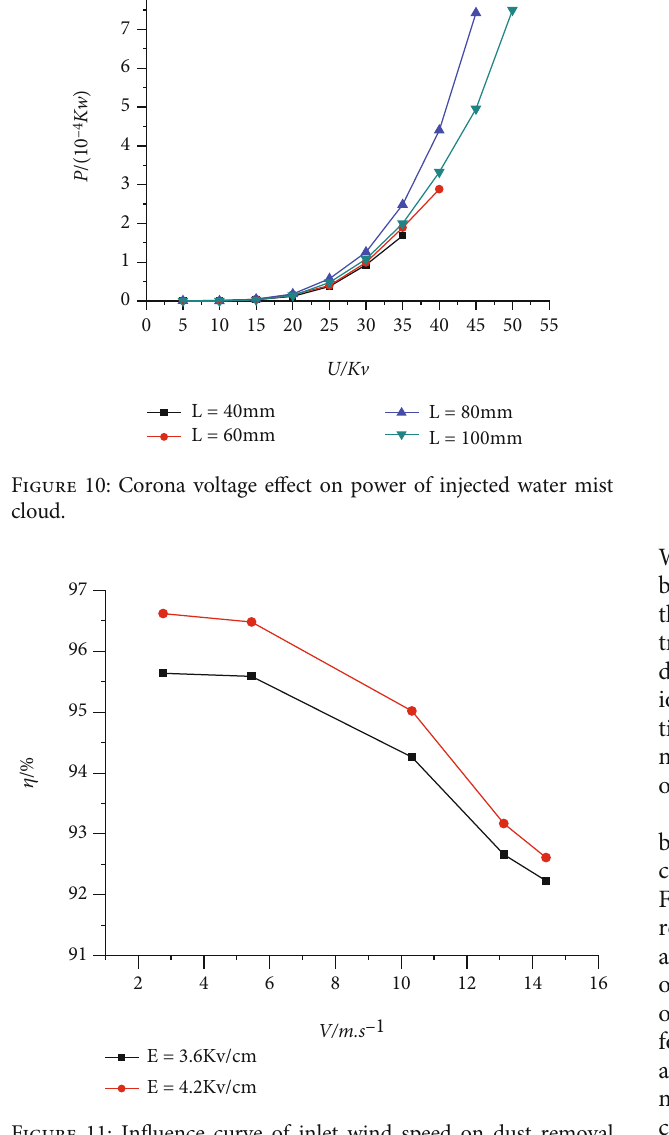
Figure 11: In fl uence curve of inlet wind speed on dust removal e ffi ciency.